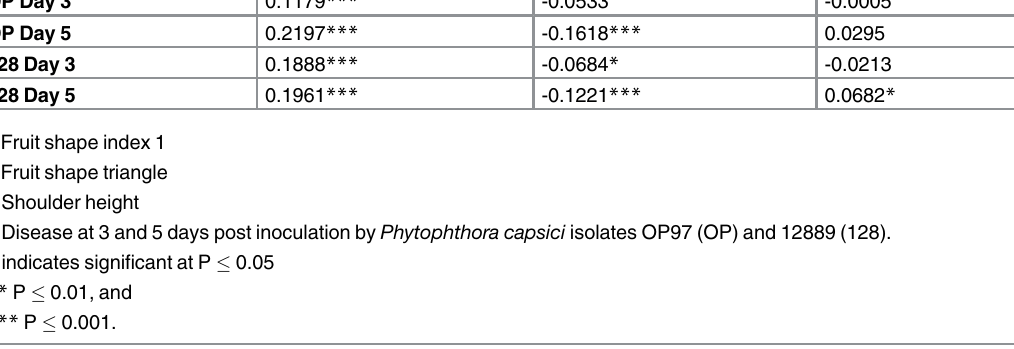
Table 7. Pearson ’ s correlation coefficient (r) between pepper fruit traits and disease resistance to Phytophthora capsici .